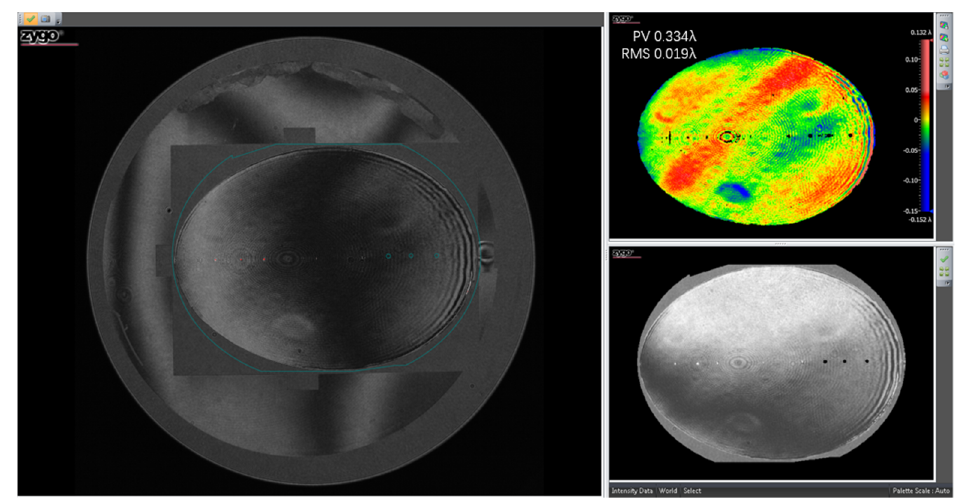
Figure 24. The mirror surface error before temperature test.